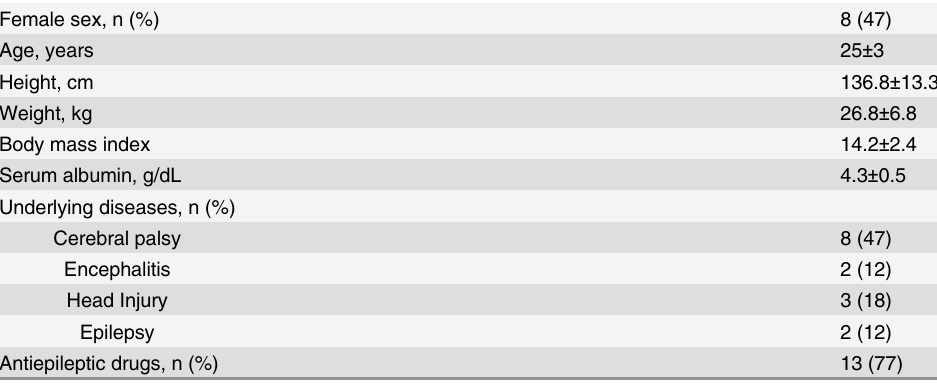
Table 4. Baseline characteristics in 17 patients < 30 years followed for 12 years.